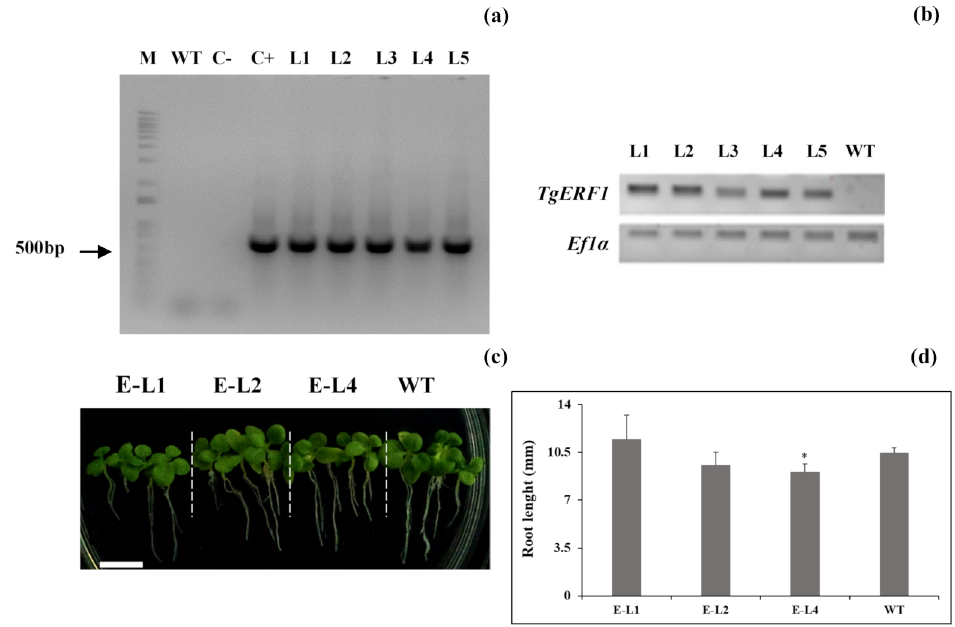
Figure 6. Molecular and phenotypic characterization of transgenic tobacco plants overexpressing the TgERF1 gene. ( a ) Representative electrophoresis analysis of PCR amplification of the 35S::TgERF1 (520 bp fragment). Lane M: molecular weight marker (1-kb DNA ladder); Lane WT: wild-type genomic DNA. Lane C-: reaction mixture without DNA template as a negative control. Lane C+: plasmid DNA as a positive control. Lane L1, L2, L3, L4, and L5: kanamycin-resistant plants from putative transgenic events; ( b ) Expression of TgERF1 in WT and transgenic lines. Leaf tissues were examined by semiquantitative RT-PCR. The constitutive NtEF1 α ( Elongation Factor-1 alpha ) housekeeping gene was used as an internal control; ( c ) Picture of 7-day-old WT and transgenic seedlings (E-L1, E-L2, E-L4) grown on MS culture medium. Bar: 1 cm; ( d ) Roots’ elongation rates. Bars represent a mean value of 20 seedlings/line ± SEM. Significant differences were determined by ANOVA followed by Dunnett’s test. * Significant at p <